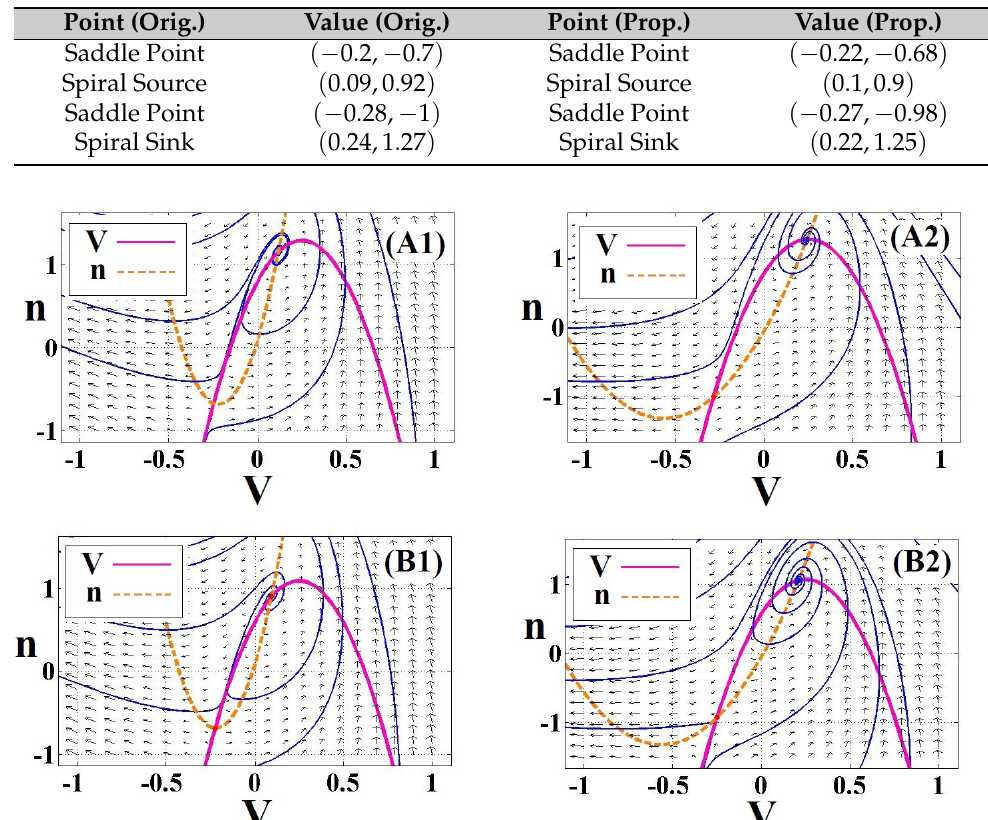
Figure 3. Dynamical behaviors for the original and proposed models. ( A1 , A2 ): Dynamics for the Class I and Class II patterns in the original model. ( B1 , B2 ): Dynamics for the Class I and Class II patterns in the proposed model. In these tates, n is the slow variable and V is the membrane potential. The equilibrium points of two original and proposed models are the